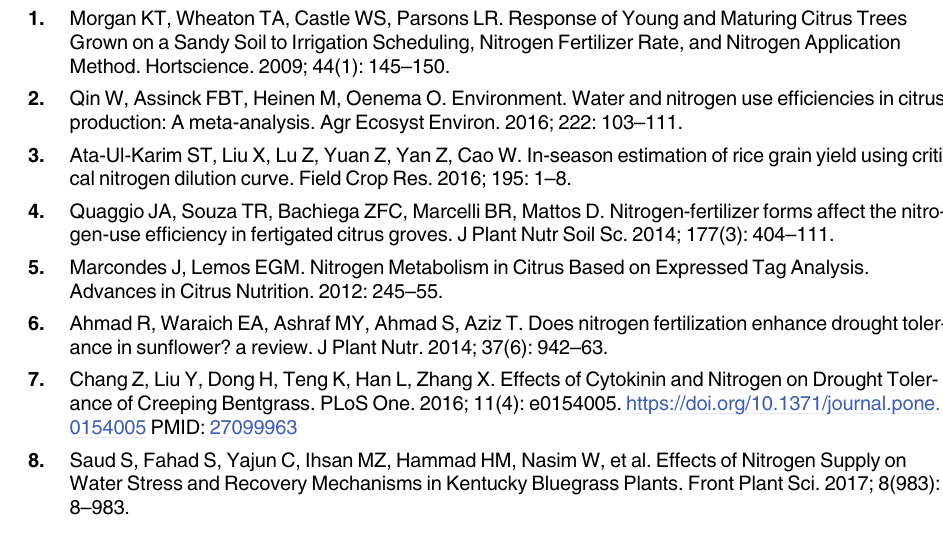
S1 Table. List of the NR, NiR, GS, GDH, and AS sequences used in phylogenetic tree analy-